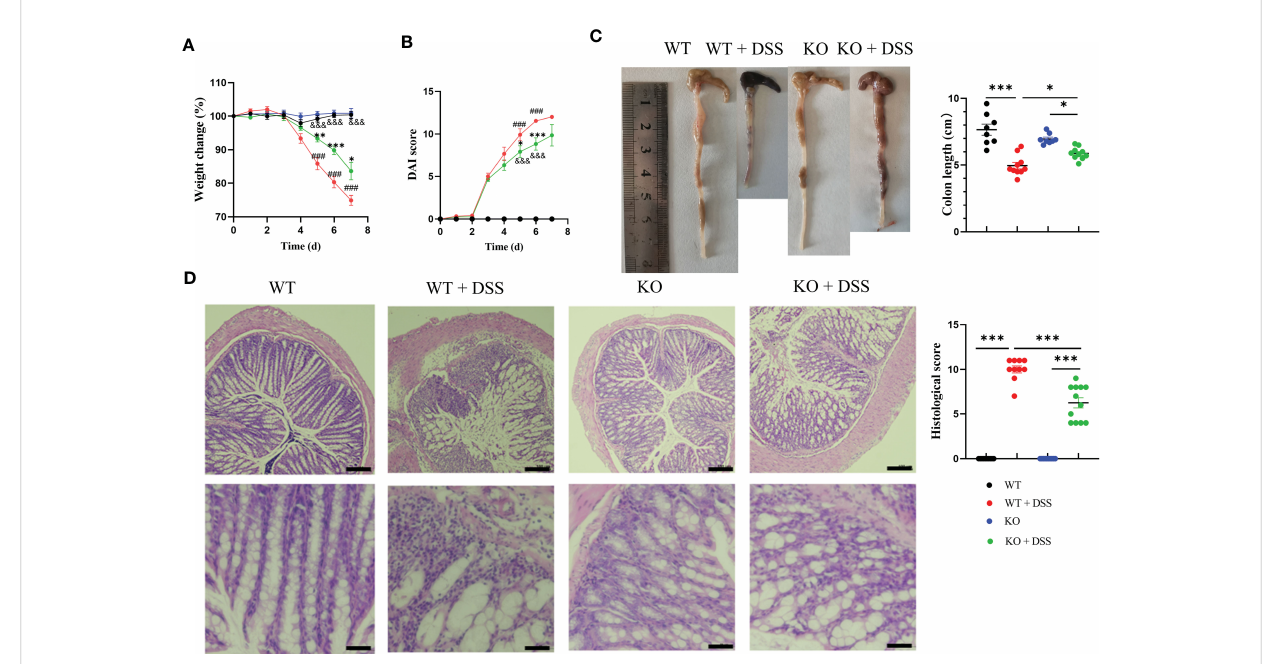
FIGURE 2 The effect of PAD4 de fi ciency on disease indexes in acute DSS-induced colitis mice. (A) Weight change. (B) DAI score ( ### P<0.001 compared with WT group; * P<0.05 , *** P<0.001 compared with WT+DSS group; &&& P<0.001 compared with KO group). (C) Colon length (n=8-10). (D) Microscopic total damage scores and representative H&E-stained colon sections of mice (n=10-12). Bars represent 100 µm in the low magni fi cation (10×; the upper panel) and 50 µm in the higher magni fi cation (20×; the bottom panel) images. The histological scores were assessed as described previously (27). * P<0.05 , ** P<0.01 , *** P<0.001